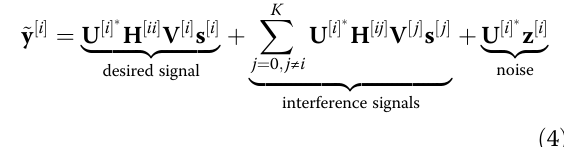
where d k is the desired number of streams of user i . V [ j ] ∈ ℂ M × d and U [ i ] ∈ ℂ N × d denote precoding matrix of j th user and decoding matrix of i th user, respectively. U ½ i (cid:2) (cid:3) is the conjugate transpose of U [ i ] . We can represent the received signal recovered by decoding matrix and adjusted by precoding matrix from the IA design conditions as follows.